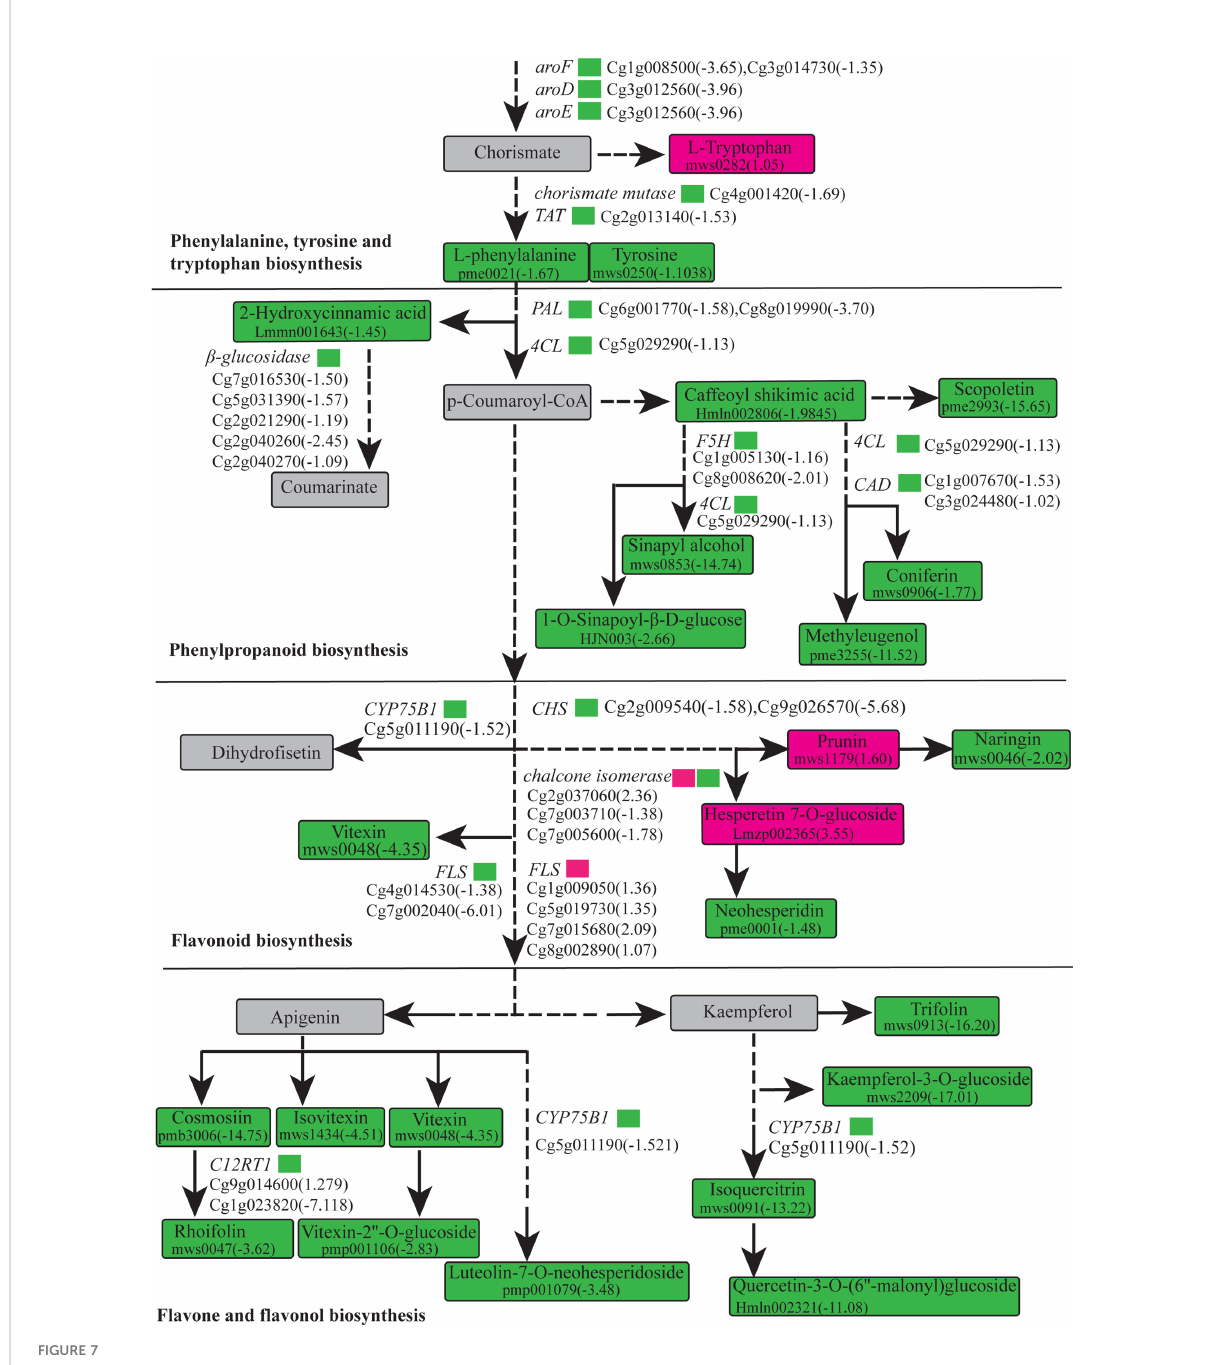
FIGURE 7 Biosynthetic pathway of the phenylpropane